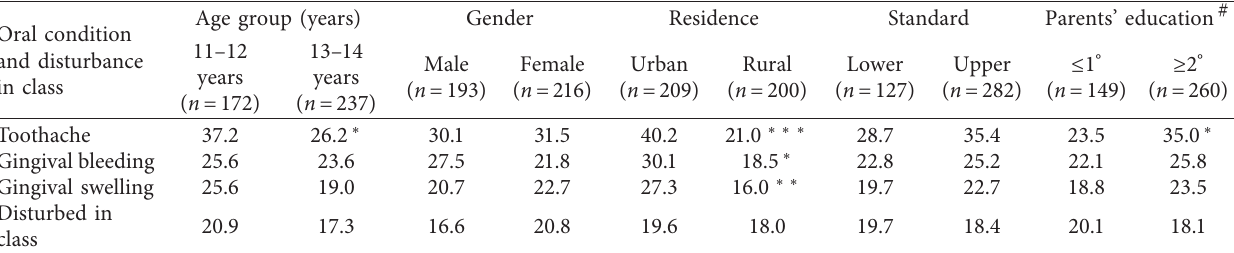
Table 4: Distribution of study participants in relation to toothache experience, disturbances in class, gingival bleeding, and swelling by sociodemographic